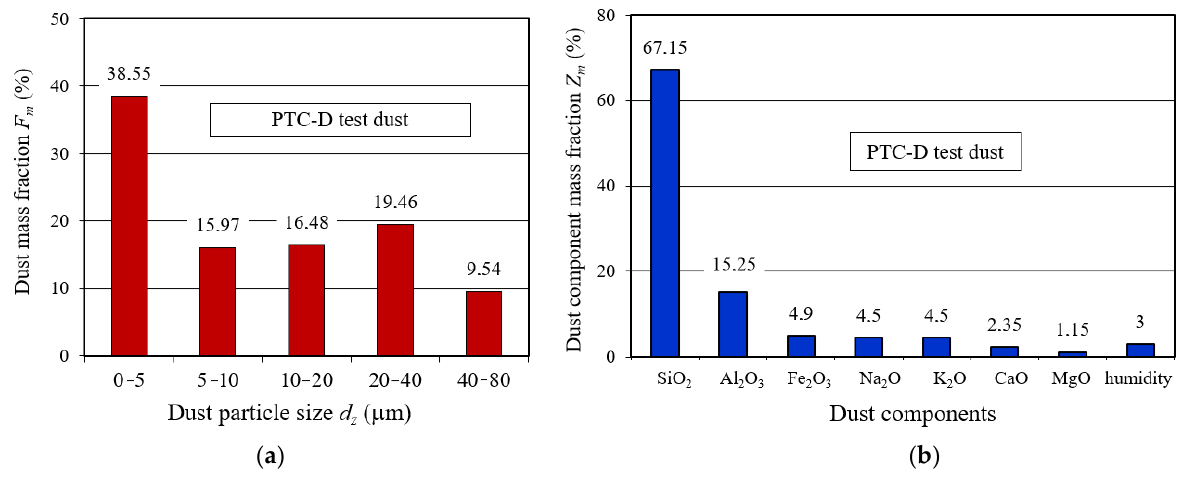
Figure 7. PTC ‐ D test dust: ( a ) mass fraction of individual fractions in the dust; ( b ) components mass fraction in the dust.